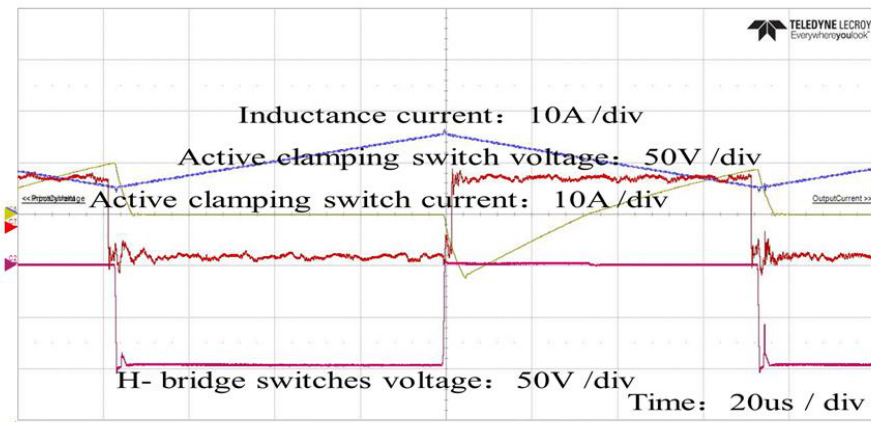
Figure 14. Drive signals of active clamping and H-bridge switches.